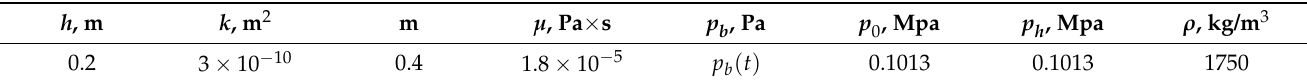
Table 2. Parameters used in data processing.